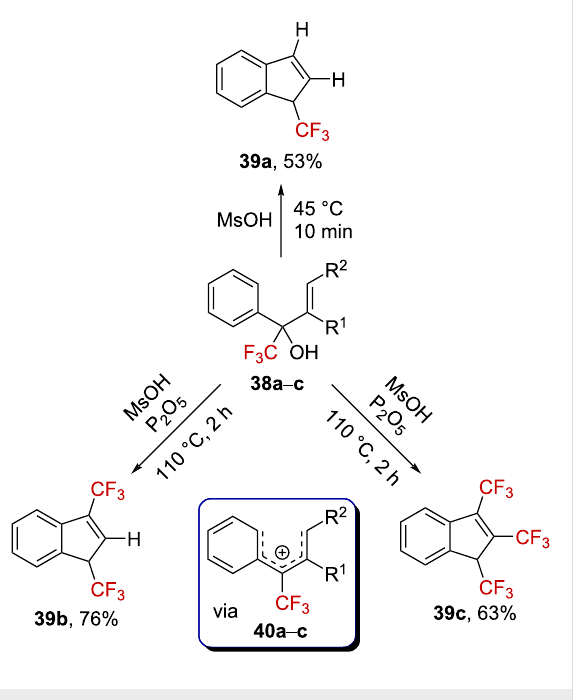
Scheme 9: Cationic electrocyclization of 38a – c under strongly acidic conditions.